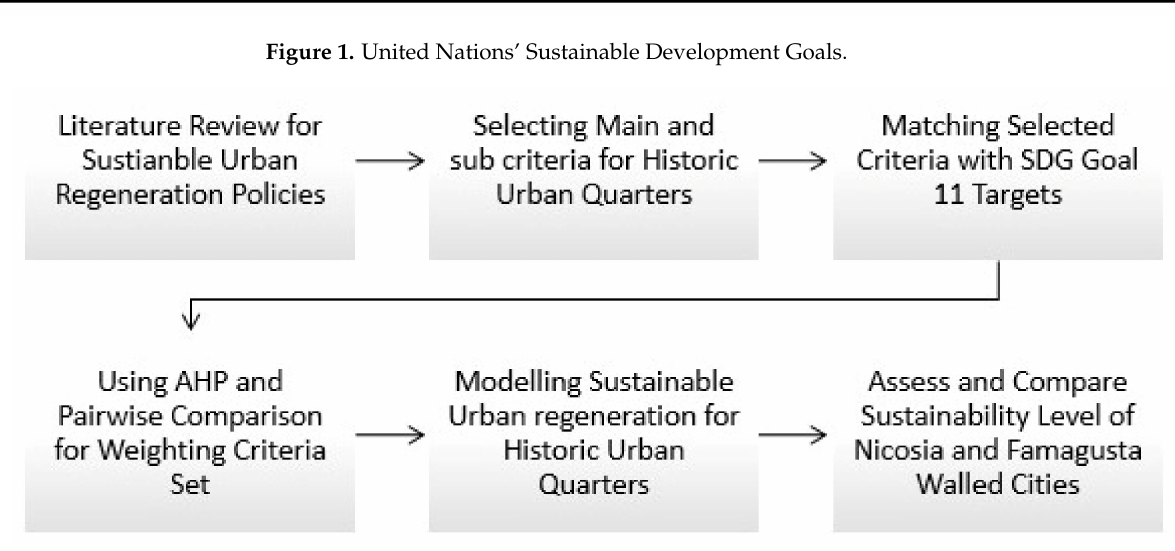
Figure 2. The framework of the